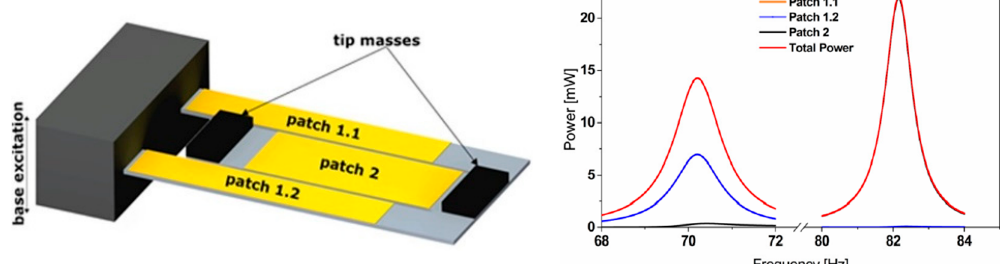
Figure 1. Arrangement of piezoelectric patches for energy conversion of the folded beam segments ( left ) and the estimated power output of the dual-frequency energy harvester ( right ).